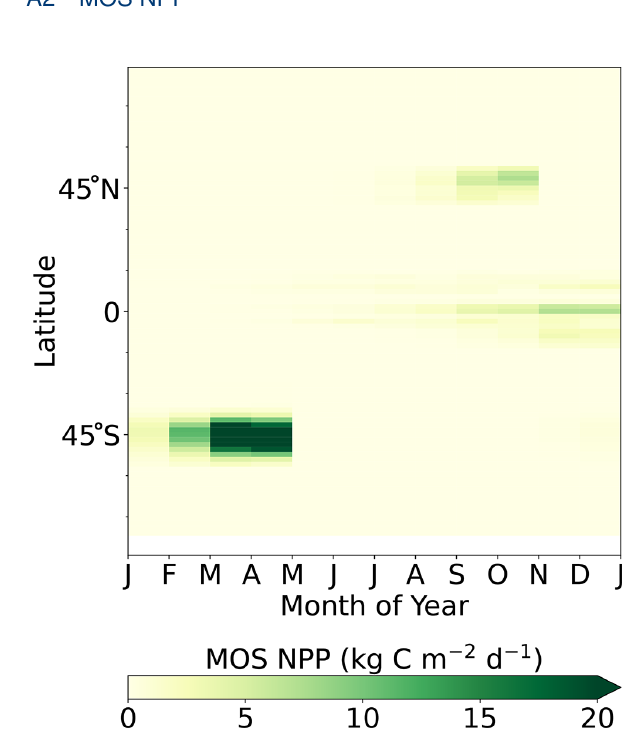
Figure A2. Hovemoeller plot of latitudinally and vertically inte- grated MOS NPP. High NPP are found in the Southern Ocean. The change of MOS NPP follows the seasonal solar radiation in UVic ESCM.